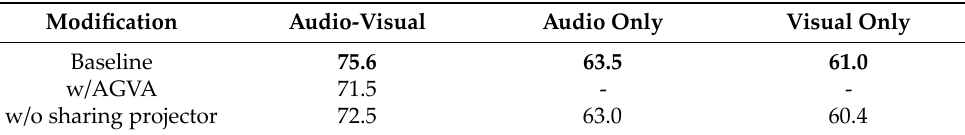
Table 4. Ablations on the architecture of the representation network. The best performance is in bold . Note that when applying an interaction module such as AVGA, the feature extraction network is no longer able to encode features under single modal data